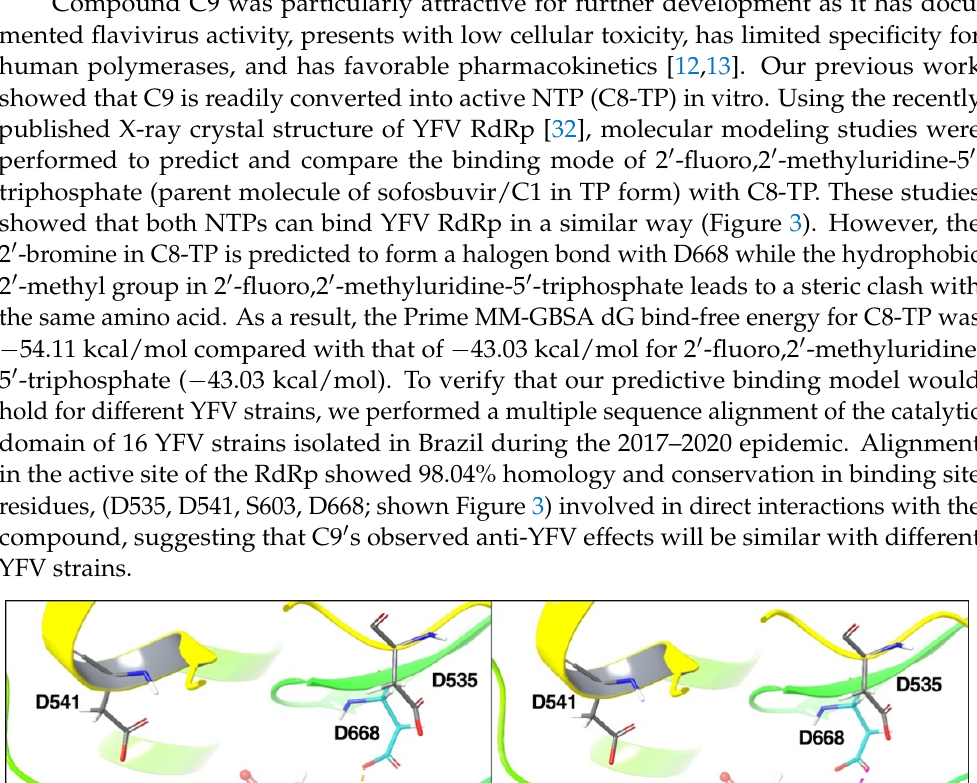
Figure 2. Intracellular metabolism of compounds into active NTP form . Huh-7 cells ( A ) or primary human hepatocytes ( B ) were plated at 10 6 cells/well and treated with 50 µM of indicated compound for 4 hr then cells were washed and collected for analysis via LC-MS for NTP formation. Data were analyzed by GraphPad Prism v9. Data shown as mean ± SEM, n = 3.